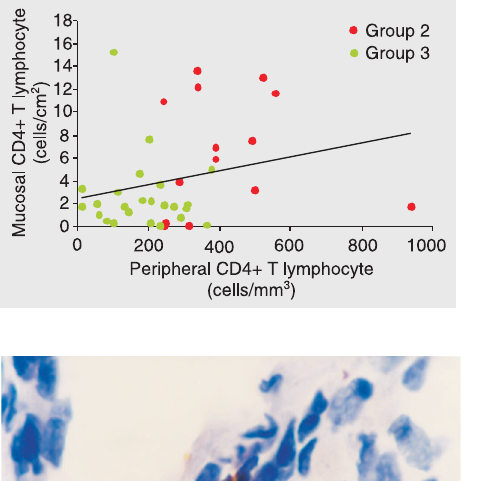
Figure 3. Immunohistochemi- cal staining at 400X for IL-4 in the lamina propria of an HIV-positive patient from group 3. Positive cell is marked in orange.